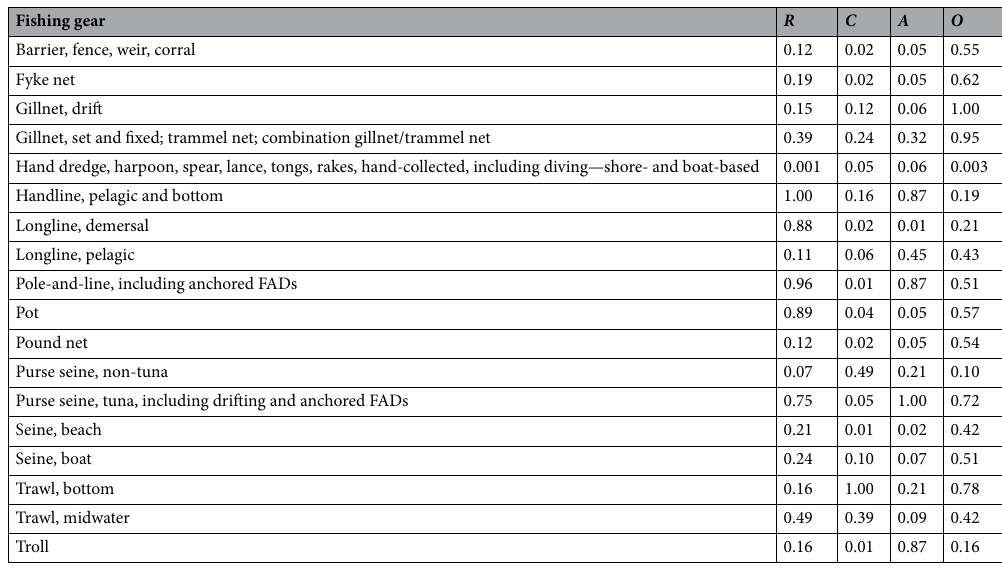
Table 2. Gear-specific relative risk scores, on a scale of 0 to 1, with 0 being no risk and 1 highest risk, for rates of the production of ALDFG ( R ), global annual catch ( C ), area of fishing grounds ( A ), and adverse ecological and socioeconomic outcomes from ALDFG ( O